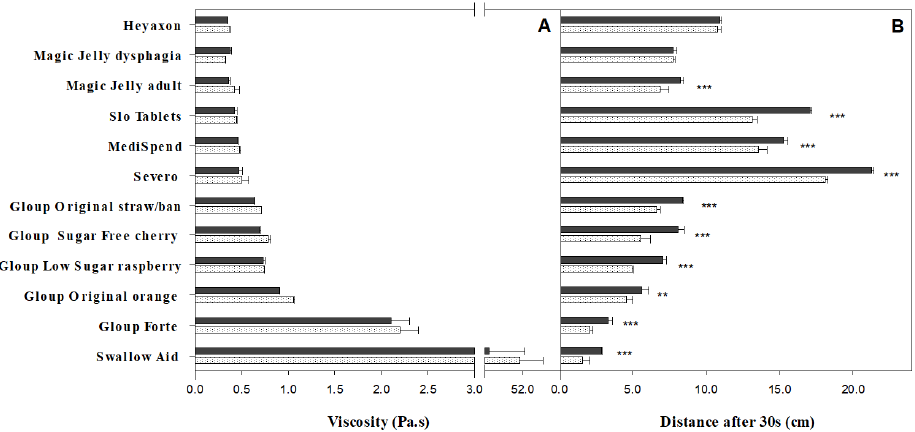
Figure 1. Viscosity and thickness consistency for medication lubricants served at room temperature, 24 °C (black bars), or fridge temperature, 4 °C (white with pattern bars). ( A ) Viscosity measured at 50 s − 1 (Pa.s) and ( B ) Bostwick thickness consistency measured as distance (cm) moved in 30 s. Statistically significant differences between measurements at room and fridge temperature are indicated (** p < 0.01. *** p < 0.001). The bars indicate mean ± se for three replicates.